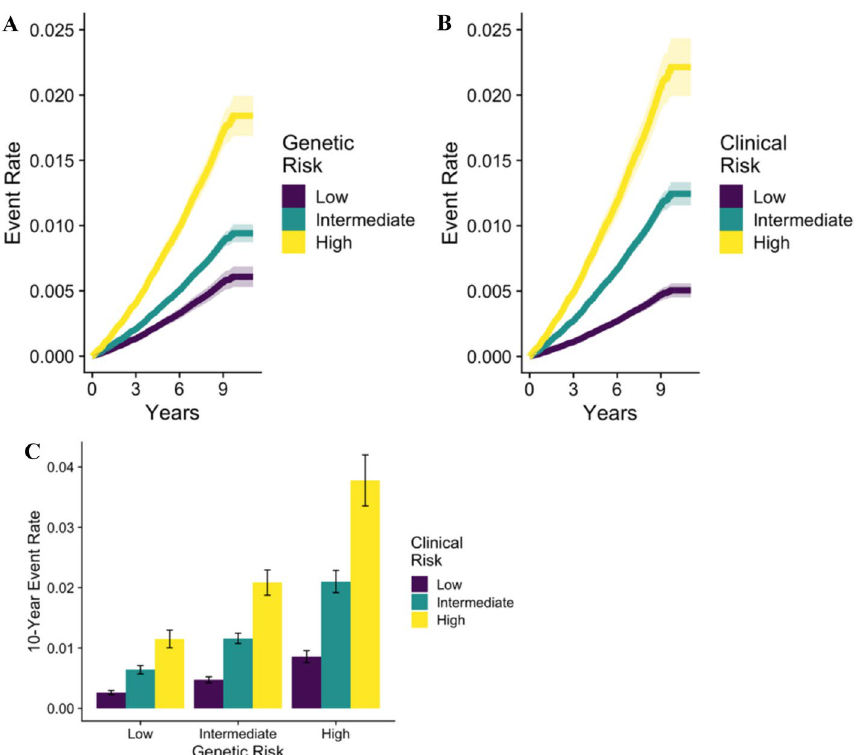
Figure 4. Prediction of venous thromboembolism. ( A ) and ( B ) Show the rates of venous thromboembolism derived from Fine-Gray models for the genetic and clinical score, respectively. ( C ) Shows 10-year event rates for venous thromboembolism, stratified by both the clinical score and genetic score. The I bars represent 95% confidence